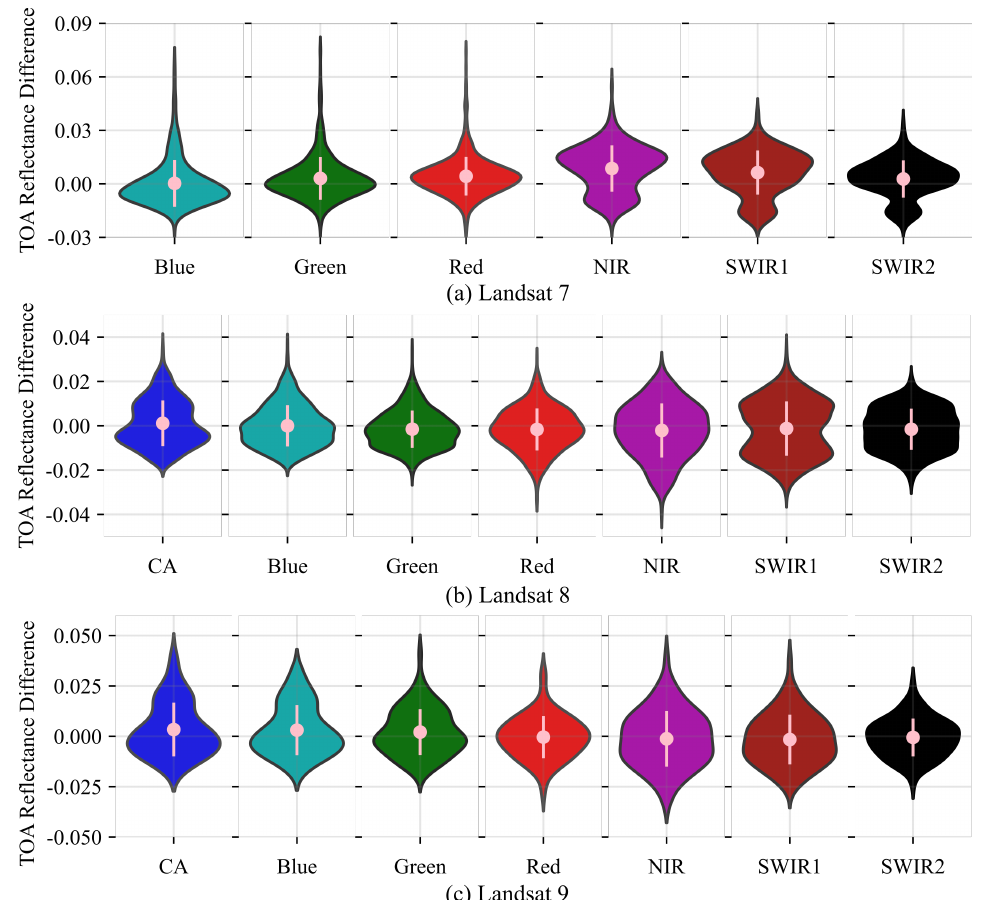
Figure 21. TOA reflectance difference between Landsats’ observed TOA reflectance and the DAHAC model’s response across seven spectral bands, showing the mean TOA reflectance difference and standard deviation